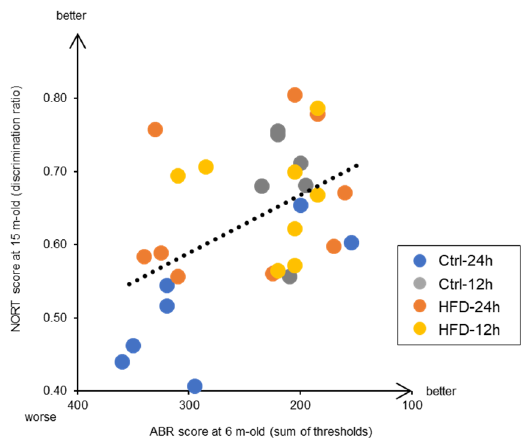
Figure 7. Correlation between middle-aged hearing and old-aged memory in SAMP8 mice: Individual results of 15 m-old NORT (Figure 5) and 6 m-old ABR (Figure 3) are plotted, and the correlation was statistically tested based on Peason’s product-moment correlation coe ffi cient ( R = − 0.49, p < 0.01, N = 30).